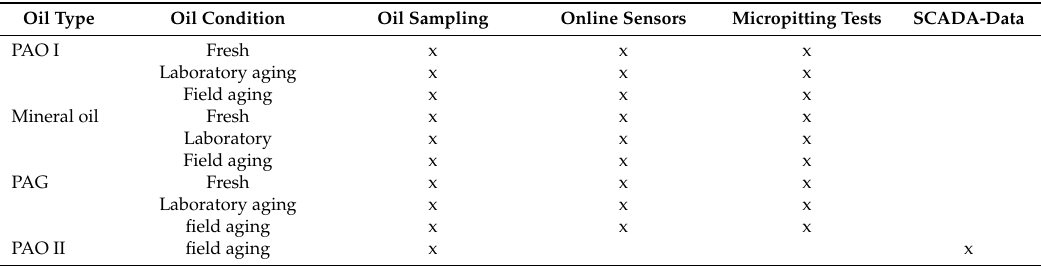
Table 1. Methods of